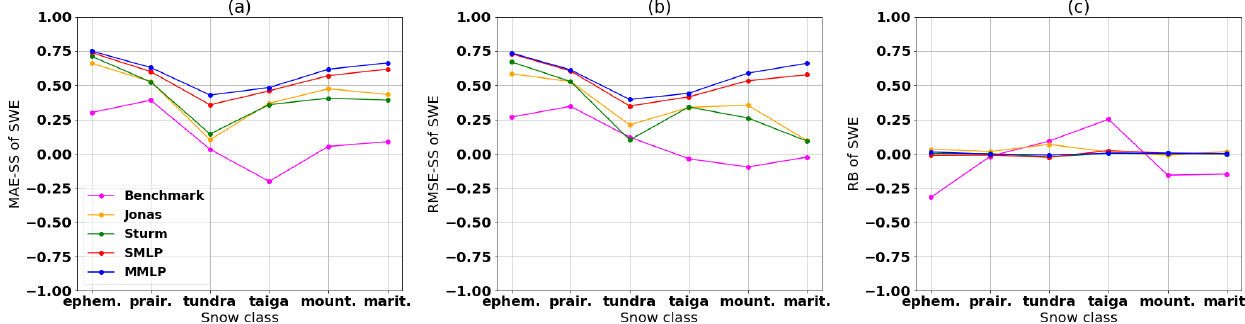
Figure 14. Comparison of the performance of the two MLP and regression models by using (a) the skill score of the MAE, (b) the skill score of the RMSE, and (c) the relative bias (RB) of the SWE simulation, as evaluated for different snow classes. Results are shown for the testing data set.